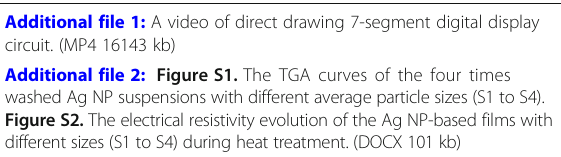
Figure S2. The electrical resistivity evolution of the Ag NP-based films with different sizes (S1 to S4) during heat treatment. (DOCX 101 kb)